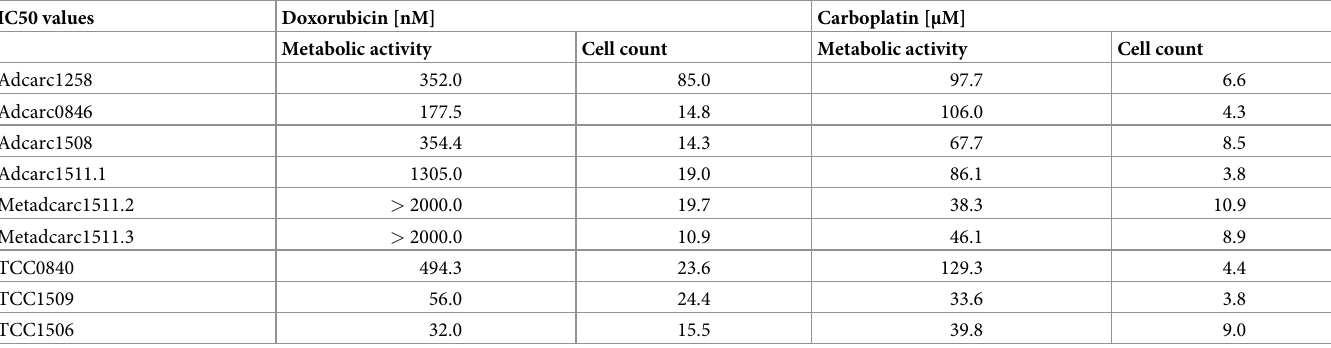
Table 4. IC50 values for doxorubicin and carboplatin after 72 h exposure, n = 3. IC50